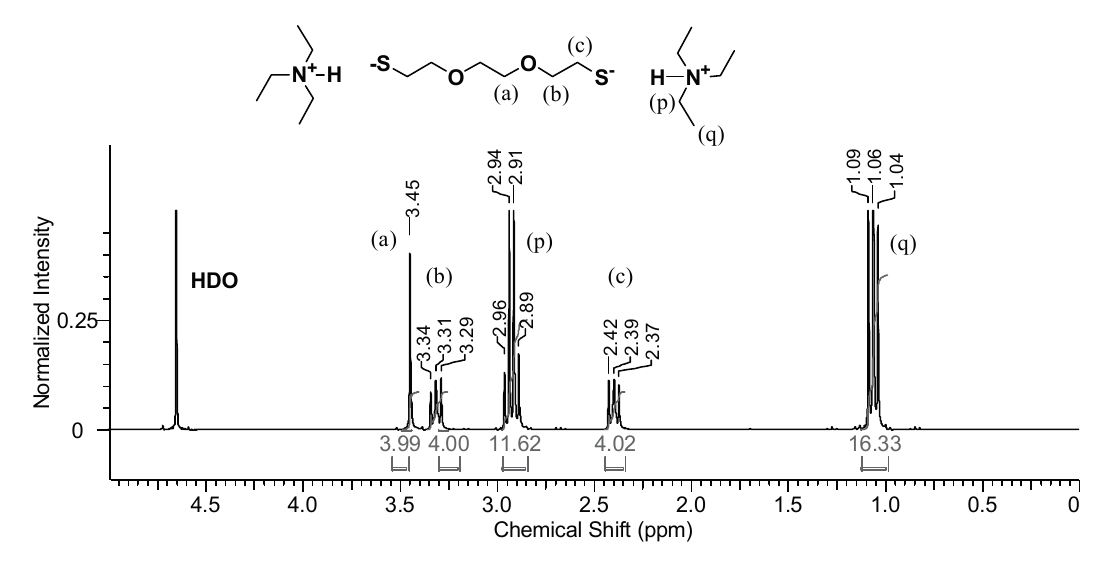
Figure 5. 1 H-NMR spectrum of the D 2 O phase after the addition of TEA to DODT/ D 2 O. (3 s relax; 64 scans; 300 MHz; D 2